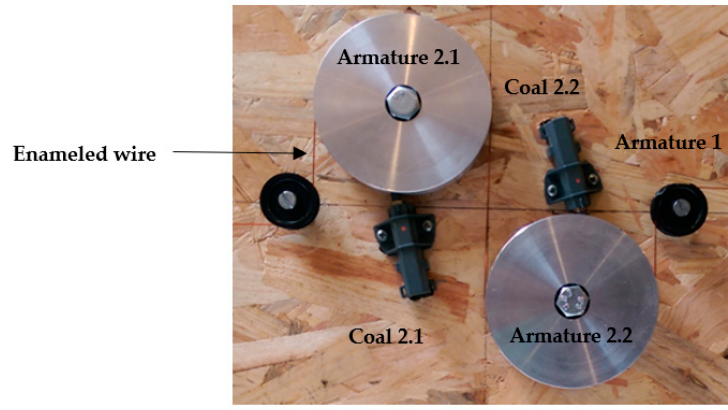
Figure 5. Synoptic system.